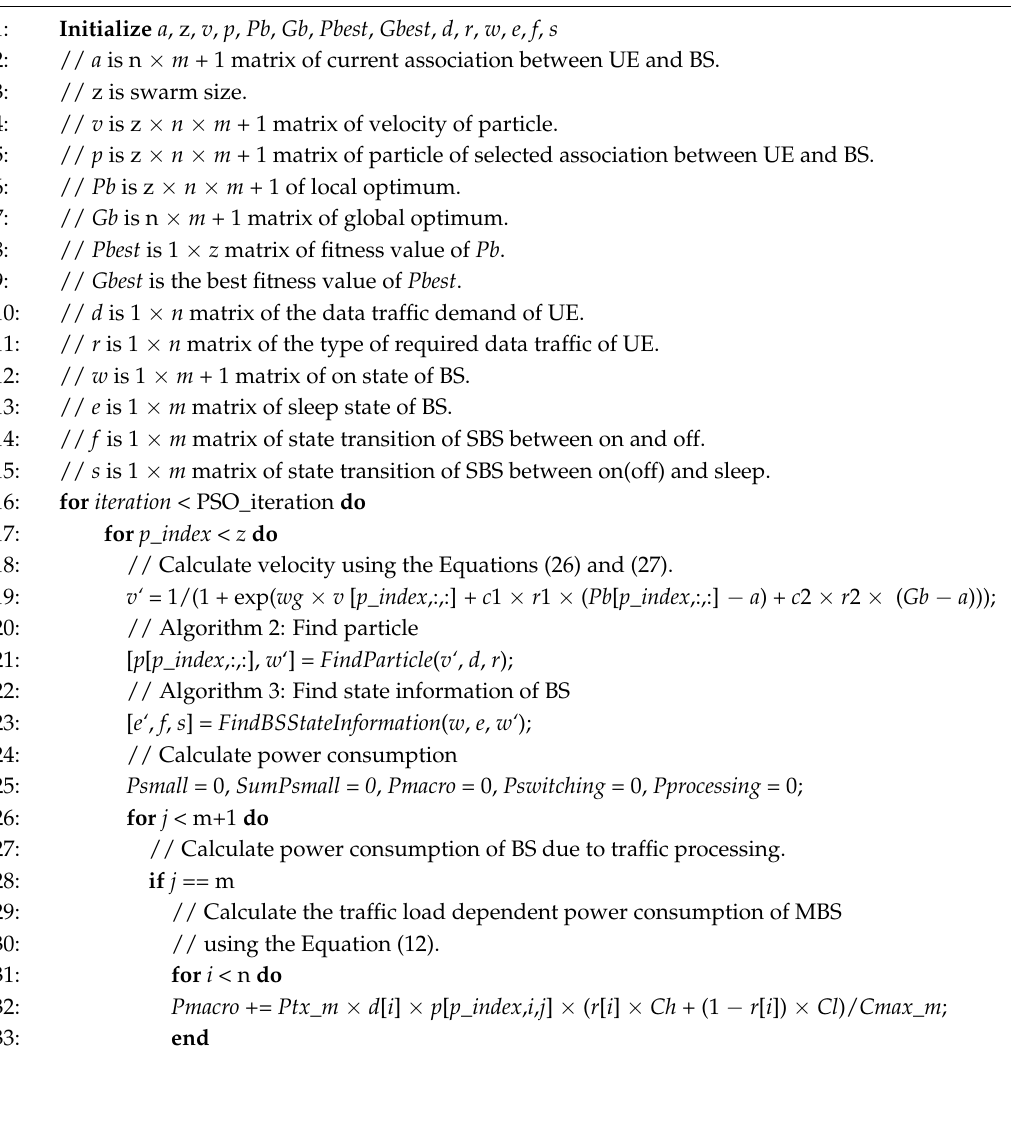
Algorithm 1. PSO